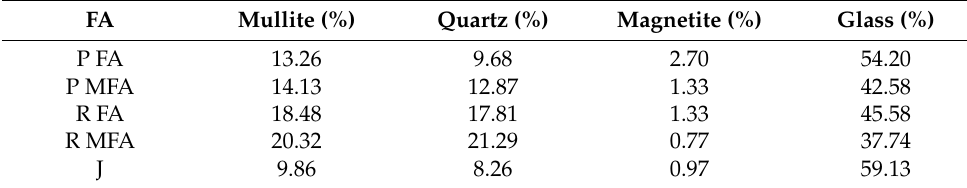
Table 4. Mineral composition of fly ash.